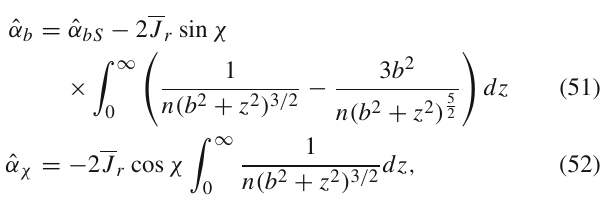
line), b / 2 M = 50 (dashed line), and b / 2 M = 100 (dot-dashed line). We assumed Λ = 0 . 5, J r / M 2 = 0 . 25, sin χ = 1, and ω 2 e /ω 2 = 0 . 5. Note that there is a small increment for b / 2 M = 10 when we compare with Schwarzschild (left panel)